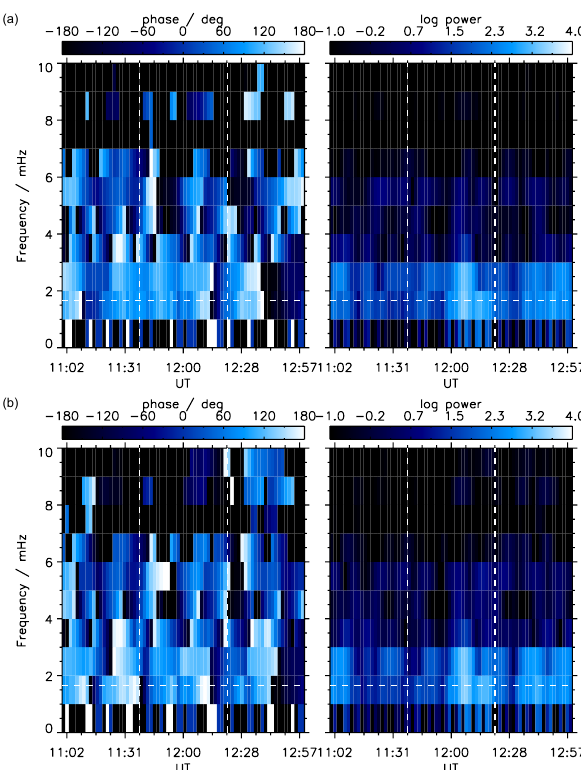
Fig. 4. Cross-phase analysis of ground magnetometer data with the SPEAR output signal, modelled as a square wave with a 10min pe- riod. A sliding analysis window of length 1000s was used, with a data point collected every 100s. (a) NAL Y component data with model SPEAR signal and (b) LYR Y component with model SPEAR signal. The right hand panel of each shows the spectral power between the two signals plotted versus time and frequency. The power has been log scaled and plotted according to the colour scale above the plot. The scale was saturated at both ends to high- light significant power relationships. The left hand panel shows the cross-phase as a function of time and frequency, between ± 180 ◦ , colour-coded according to the scale at the top. The horizontal line marks 1.67mHz frequency and the vertical dashed lines mark the limits of output obtained from windows wholly within the heating experiment.